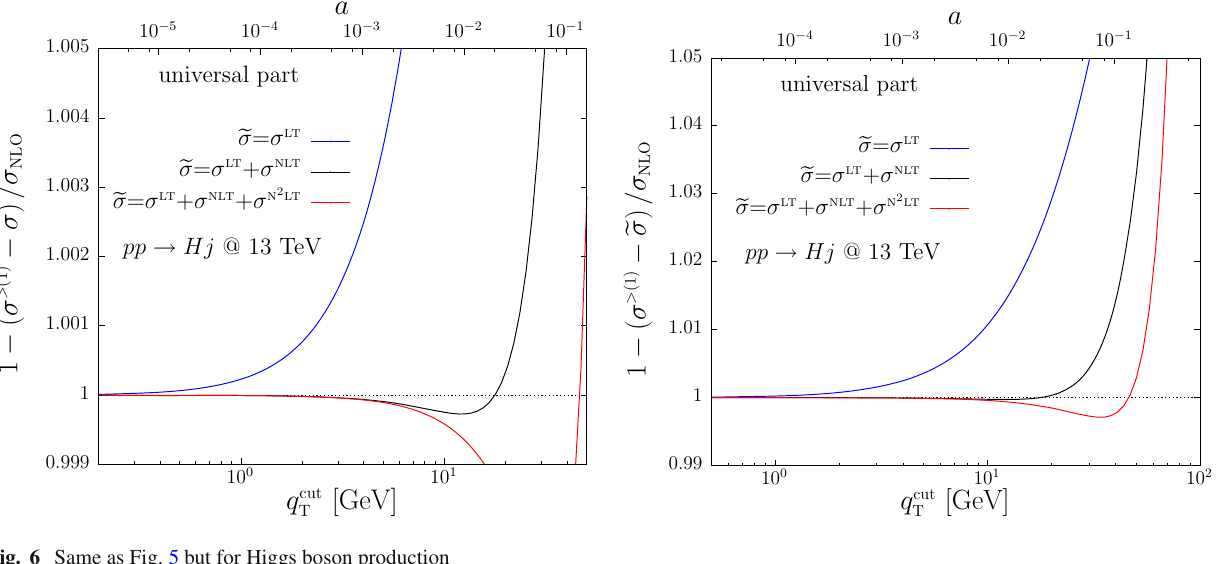
Fig. 6 Same as Fig. 5 but for Higgs boson production